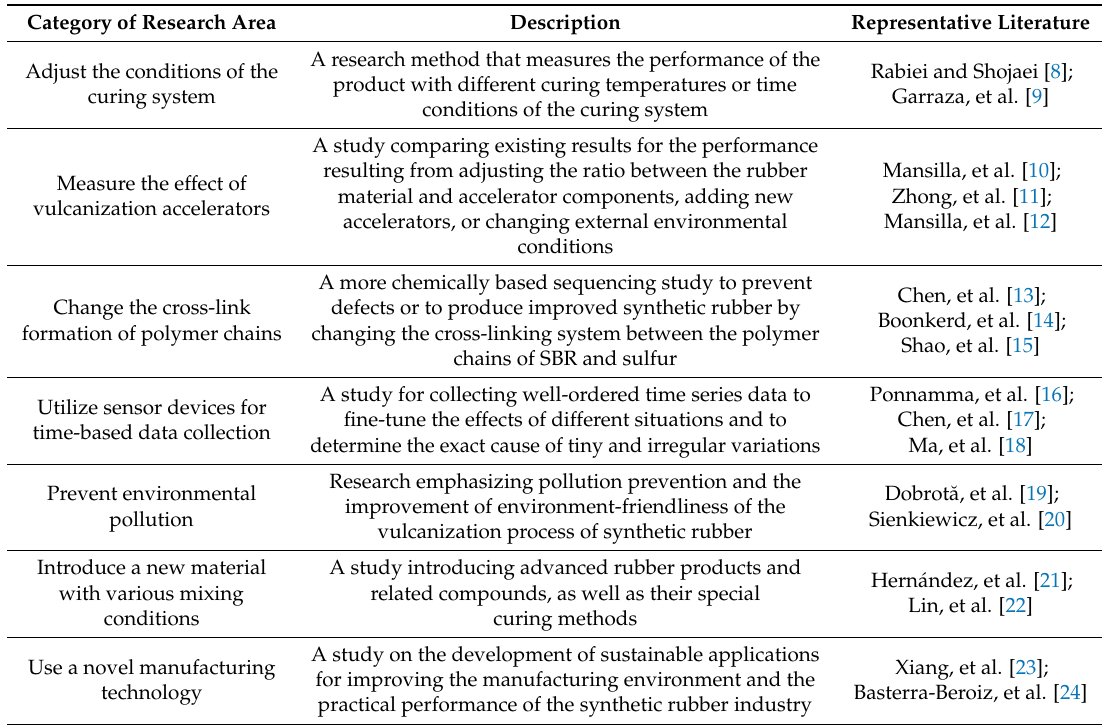
Table 2. Summary of recent studies on